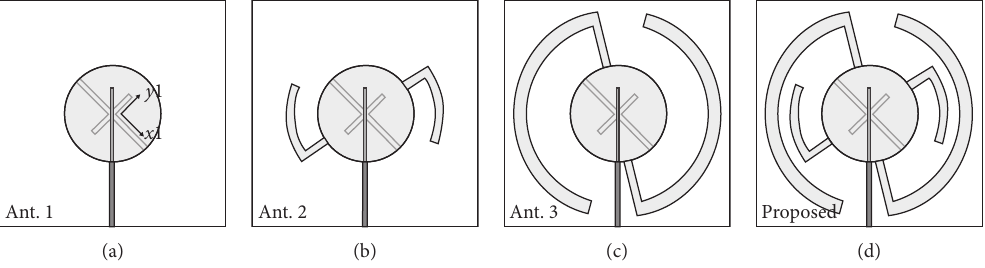
Figure 2: Four antenna prototypes in the design process.